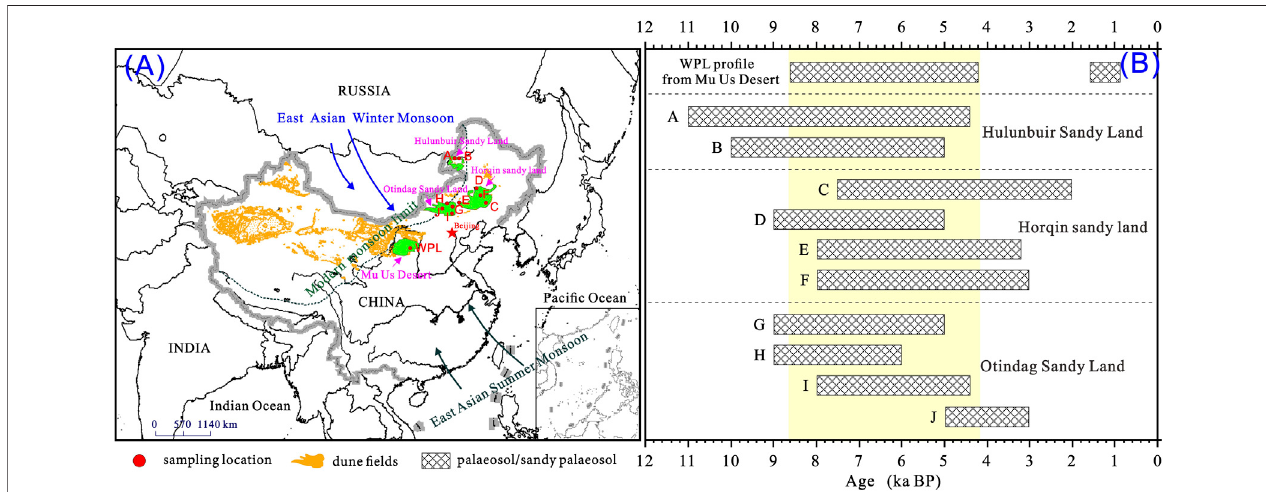
FIGURE6| Regionalcomparisons. (A) Thelocationmapofourresearcharea,theMuUsDesert,andasketchmapofthelocationsofstudiedpointsinothersandy lands in Northern China, which were shown in Figure 6B . (B) The ages of the development of palaeosol/sandy palaeosol in the monsoonal area in Northern China. In detail,A-LiandSun(2006);B-YangandDing(2013);C-Zhaoetal.(2007);D-Guoetal.(2017);E-Muetal.(2016);F-Yangetal.(2012);G-Zhouetal.(2013);H-Jin et al. (2004); I - Gong et al. (2013); J - Yang et al. (2008).